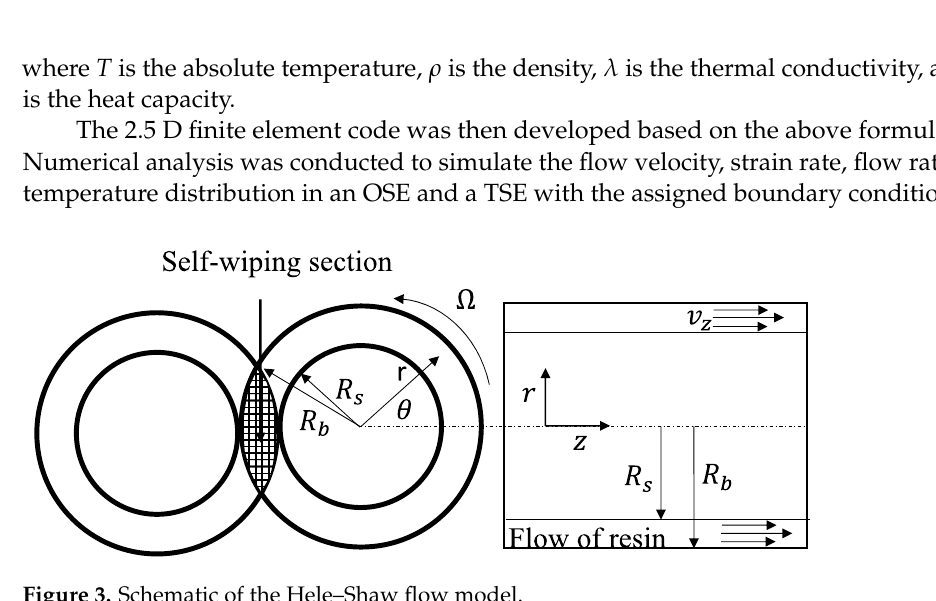
Figure 3. Schematic of the Hele – Shaw flow model.